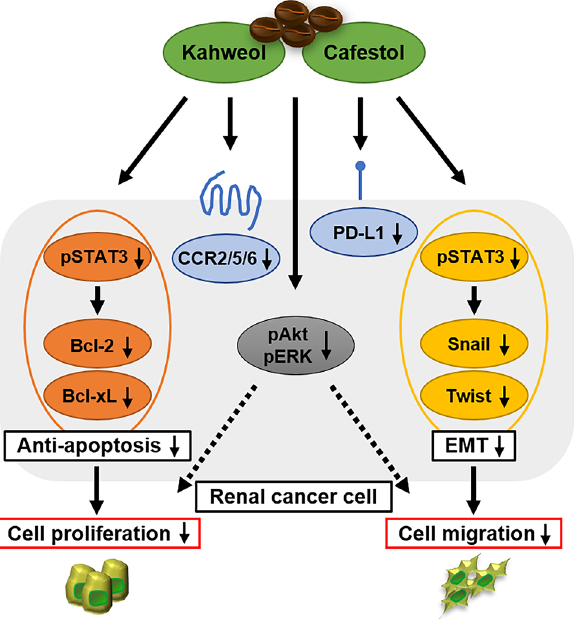
Figure 6. Schematic illustration of the anticancer mechanisms of kahweol acetate and cafestol. Kahweol acetate and cafestol inhibited cell proliferation and migration by inducing apoptosis and inhibiting epithelial– mesenchymal transition (orange and yellow colored molecules, respectively). Kahweol acetate and cafestol also inhibited CCR2/5/6, may potentially target the chemokine axis, and may affect the tumor immune environment by downregulating PD-L1 (blue colored molecules). Moreover, kahweol acetate and cafestol also inhibited the phosphorylation of Akt and ERK, which play central roles in tumor progression (gray colored